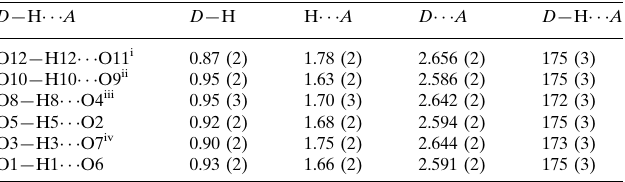
H O , crystallizes with three 11 16 4